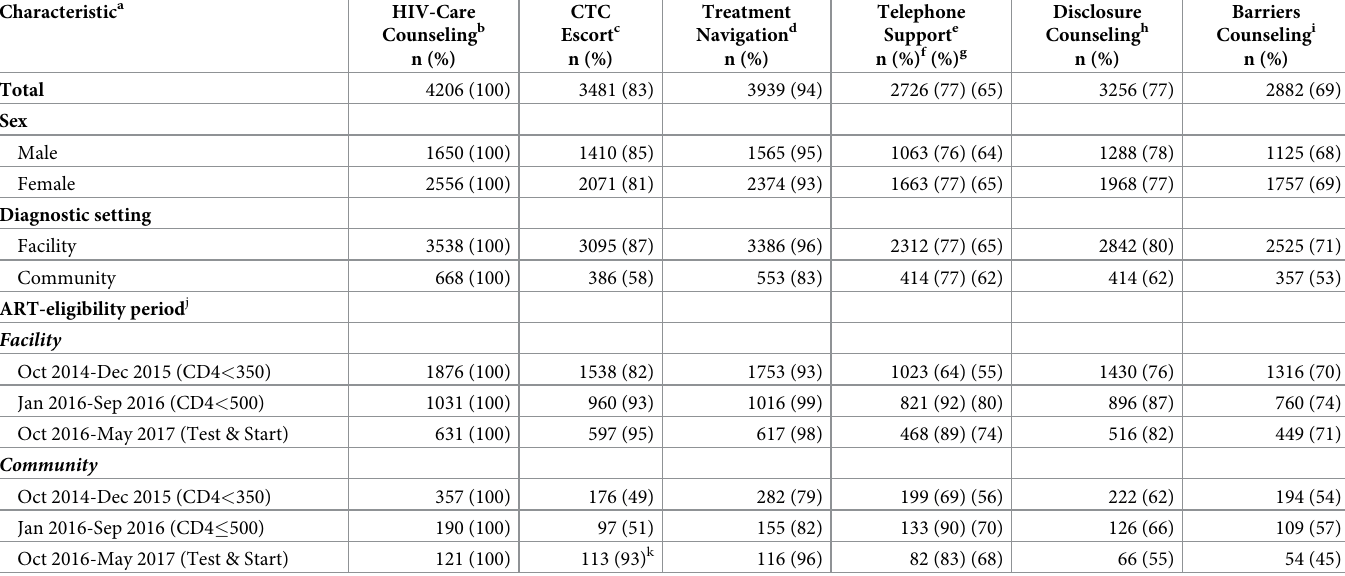
Table 2. Peer-delivered LCM service uptake, by client gender, setting of HIV diagnosis, and ART-eligibility period, Bukoba Combination Prevention Evaluation, Bukoba Tanzania, 2014–2017. a